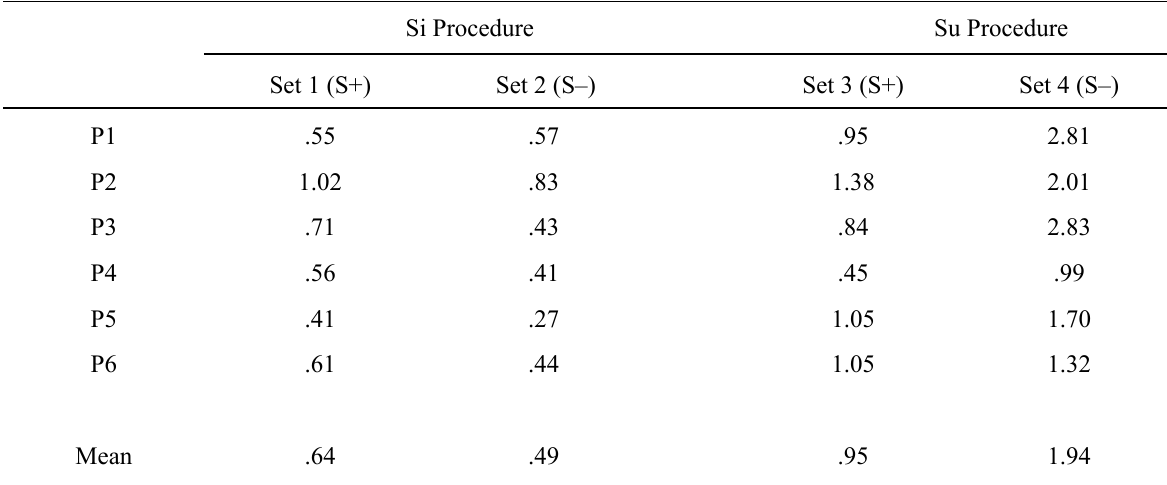
Table 1 Average Time Spent Observing the Stimuli in the Si and Su Procedures Si Procedure Su